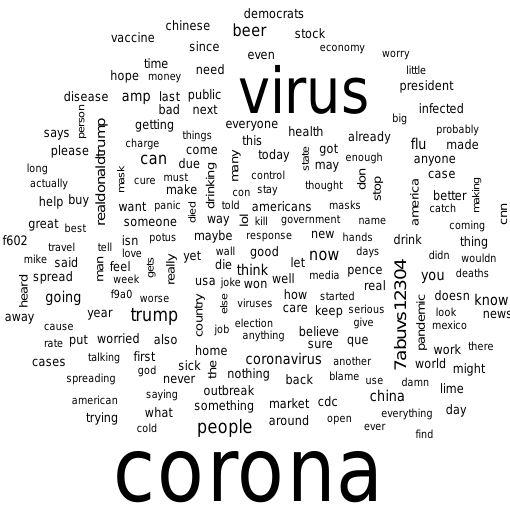
Figure 2. An instance of word cloud in twitter data.